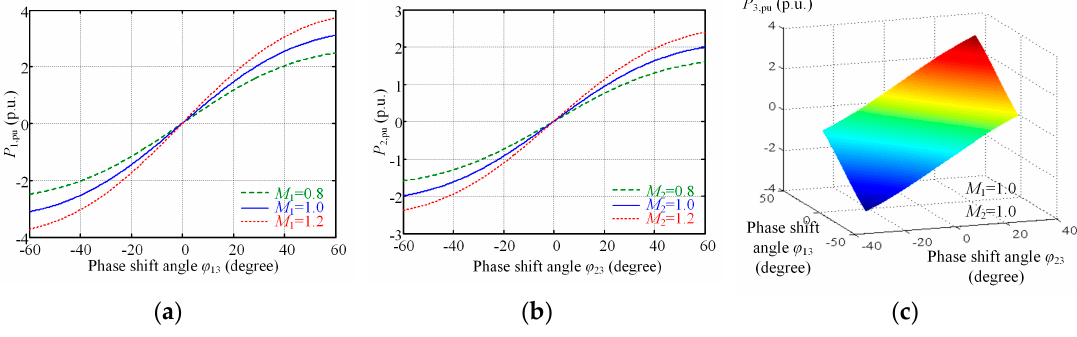
Figure 6. Output power versus phase shift angles: ( a ) P 1,pu versus ϕ 13 ; ( b ) P 2,pu versus ϕ 23 ; ( c ) P 3,pu versus ϕ 13 and ϕ 23 .